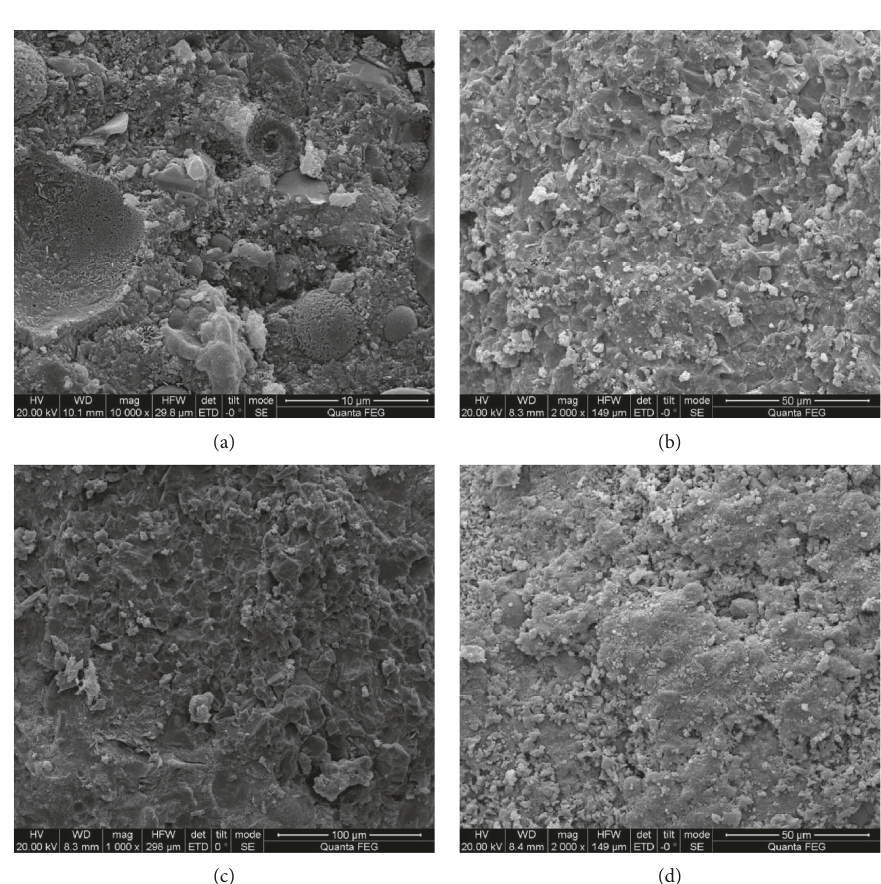
Figure 7: SEM of group S2 samples before test and after 30-day carbonation in different test modes. (a) S2, (b) S2-C, (c) S2-CF, and (d) S2-FC.